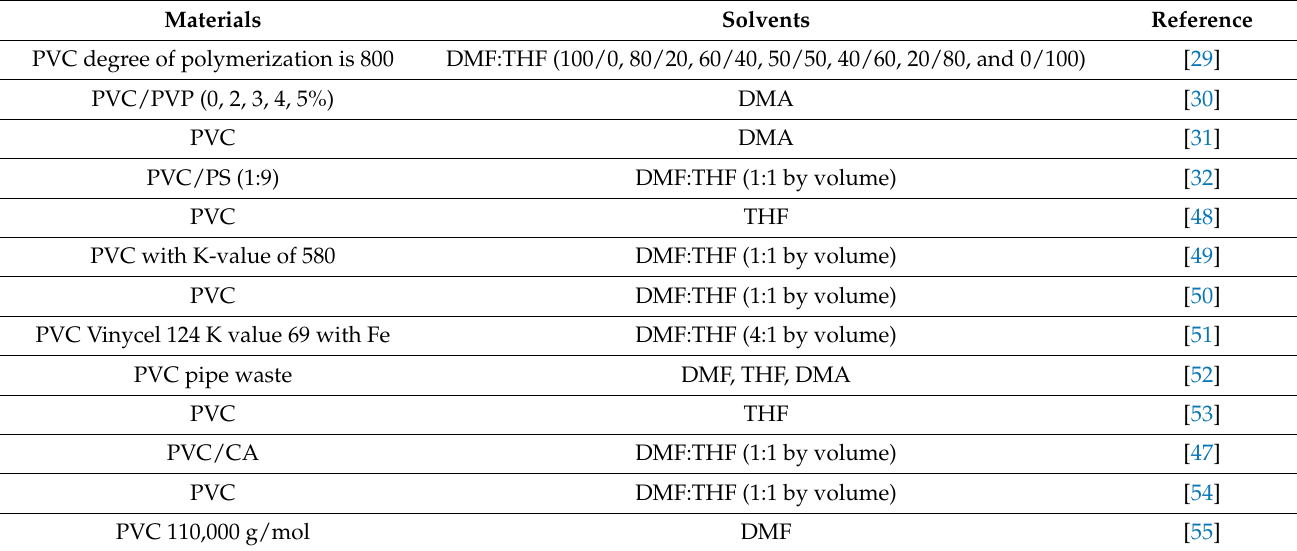
Table 1. Solvents for the fabrication of PVC